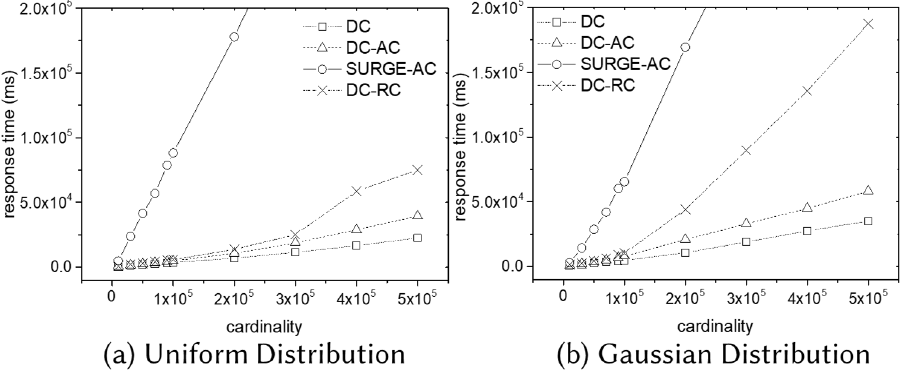
Figure 14. Effect of data size in MaxstRSC.